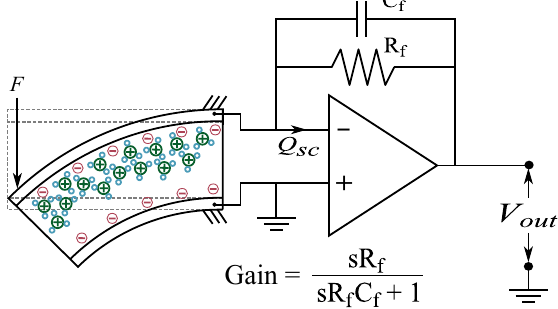
Figure 10. Principle implementation of IPMC charge